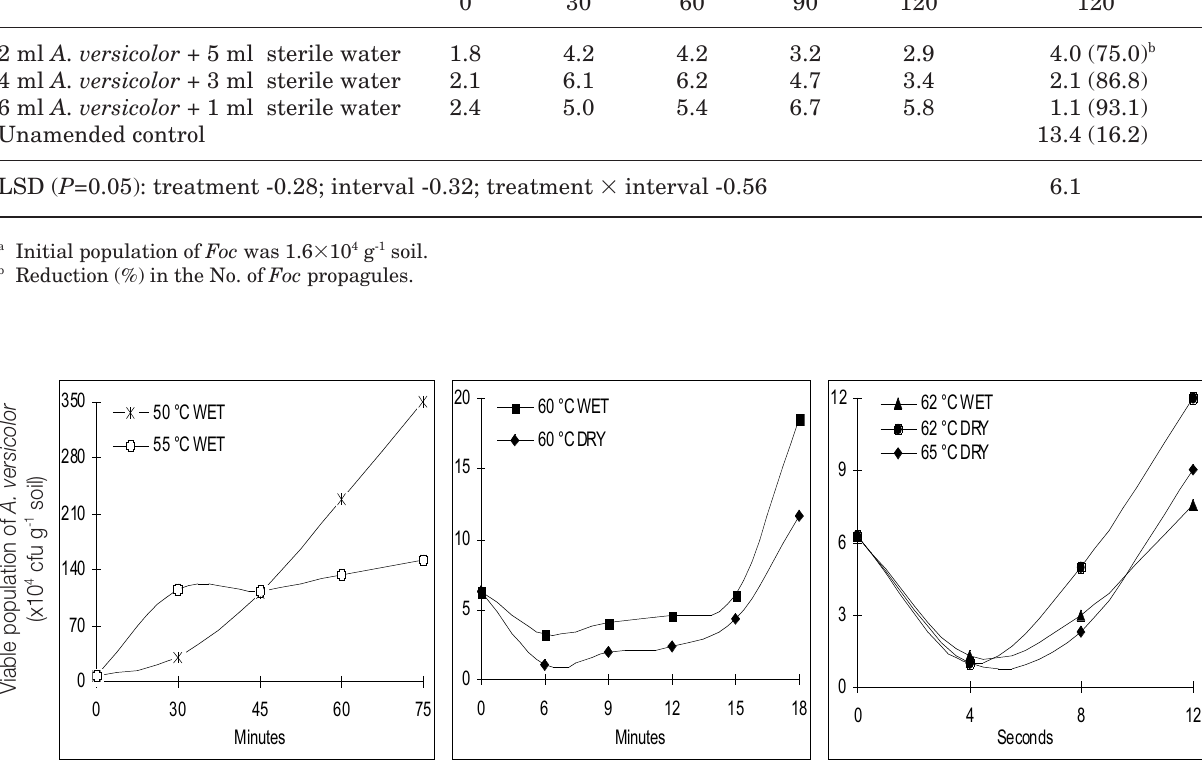
Fig. 1. Time-temperature relationship for survival of Aspergillus versicolor in wet and dry soil at 50, 55, 60, 62 and